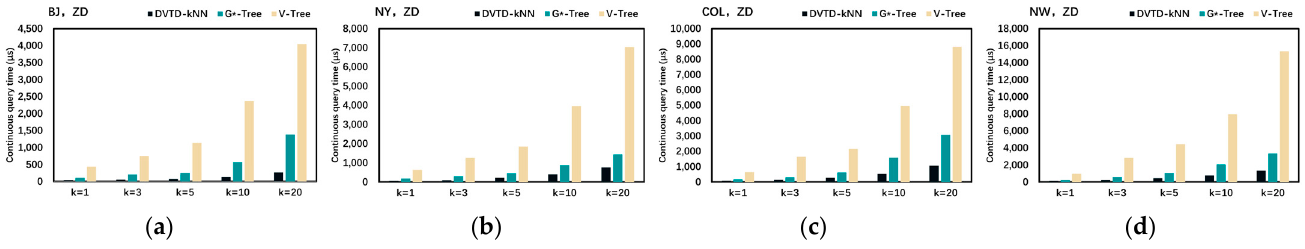
Figure 14. Comparison of query times between baseline algorithms and DVTG-C k NN w.r.t. k. ( a ) Query times on BJ; ( b ) Query times on NY; ( c ) Query times on COL; ( d ) Query times on NW.